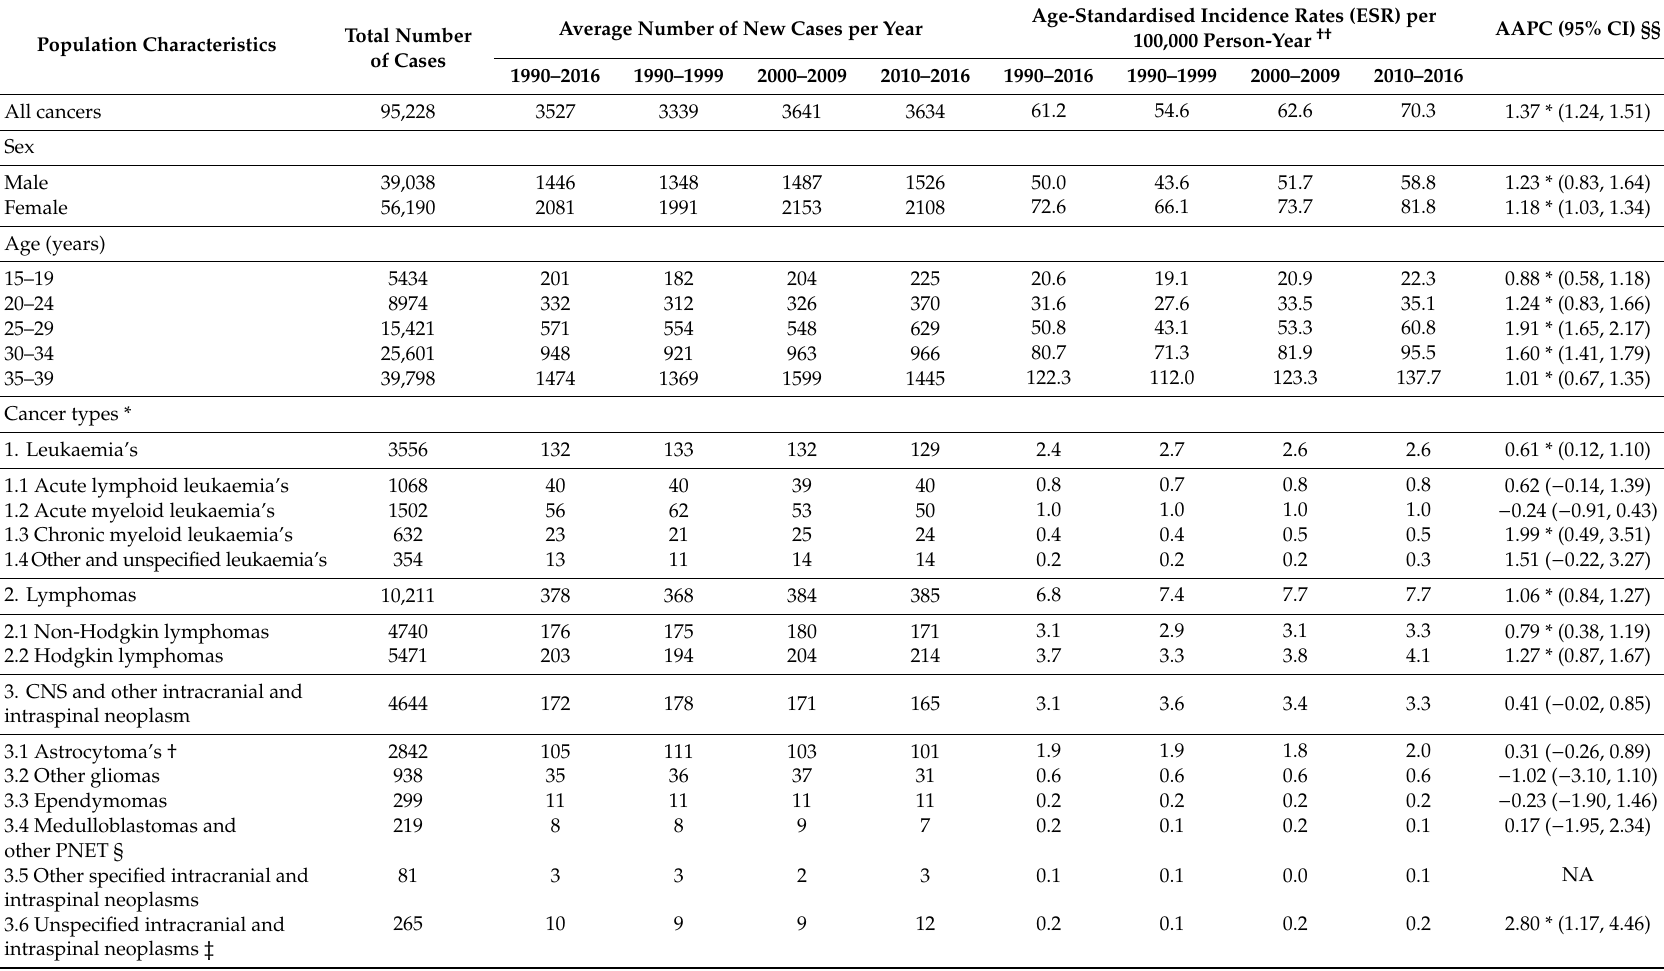
Table 1. Total and average number of new cancer cases per year, incidence rates and average annual percentage change (AAPC) estimates of all adolescents and young adults (AYAs) aged 15–39 years at time of diagnosis in the Netherlands between